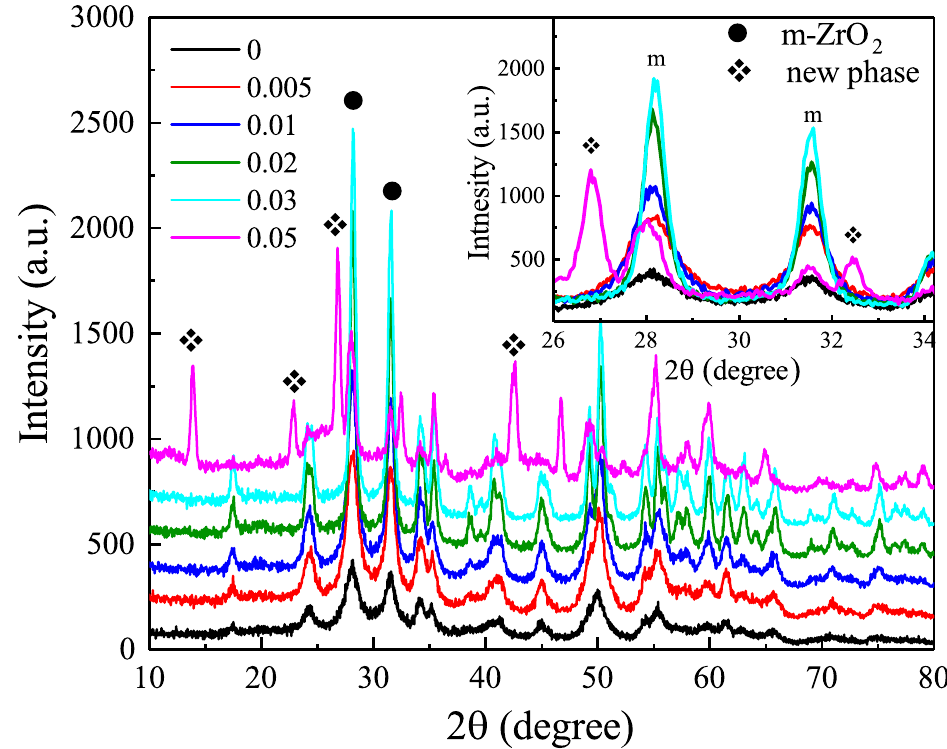
Figure 1. X-ray diffraction patterns of HT-ZrO 2 ( x ) synthesized with different concentration of NaBF 4